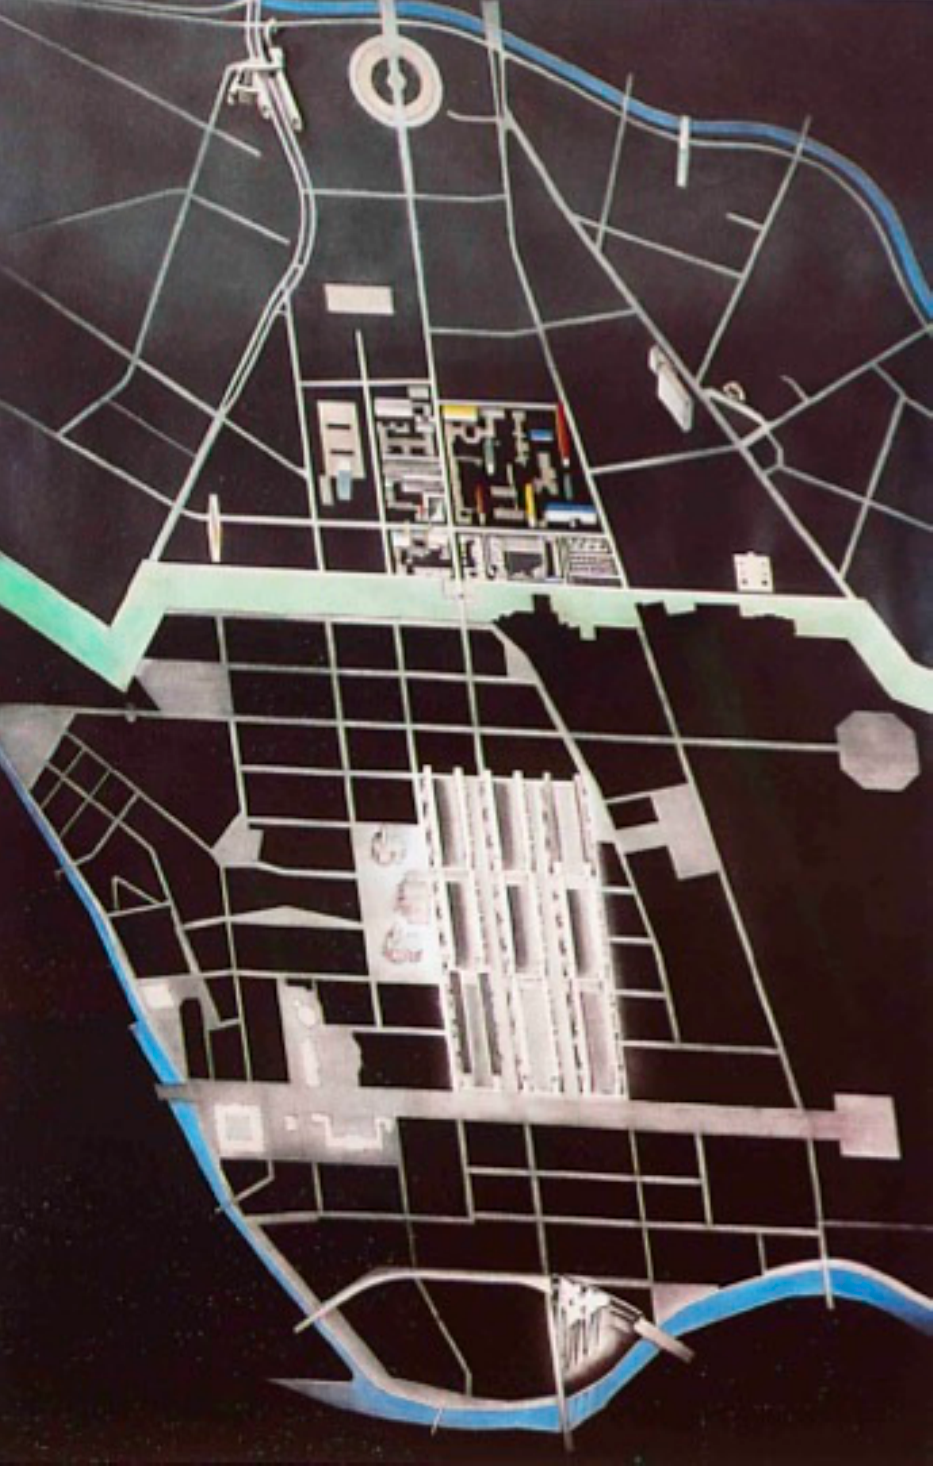
Figure 7. An illustration of the proposal of the Office for Metropolitan Architecture (OMA) for a housing complex in Berlin on Koch-Friedrich Strasse published in Jean Nouvel, Anne Laure Egg, Odile Fillion, Patrice Goulet, eds. 1982. La modernite ́ ou l’esprit du temps . Paris: L’Équerre, 72. Rem Koolhaas, Stefano de Martino, and Kees Christiaanse saw this situation as an opportunity of liberation for modern architecture, referring to the possibility of a “new” modern architecture characterised not only by intelligence and programmatic